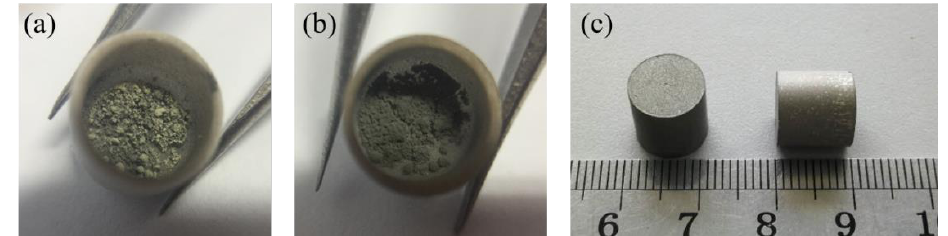
Figure 2. The samples used for DSC (differential scanning calorimetry) and quasi-static compression: ( a ) The Al-PTFE (aluminum-polytetrafluoroethene) mixture used for DSC; ( b ) the Al-Ni mixture used for DSC; ( c ) the Al-Ni-PTFE specimen used for quasi-static compression.